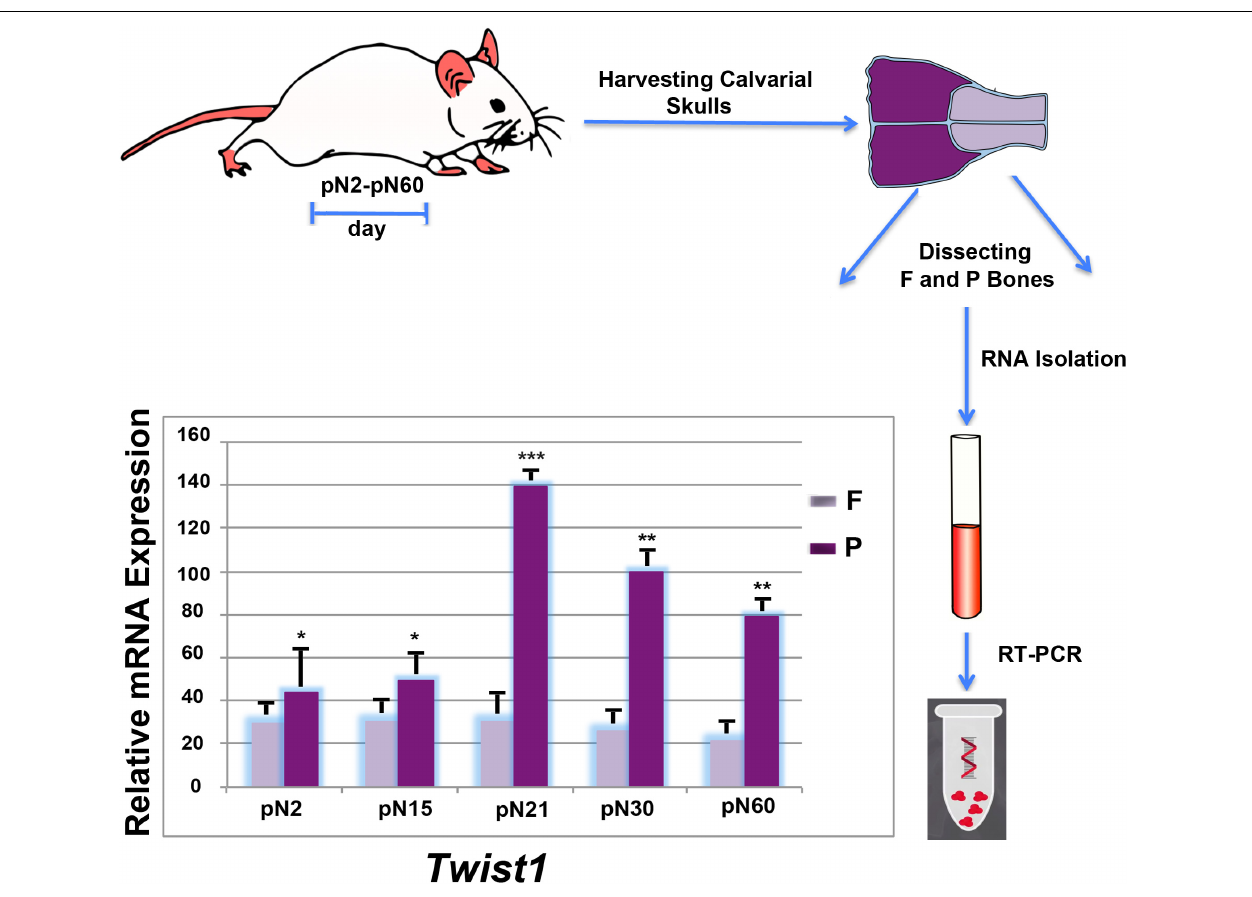
FIGURE 1 | Differential postnatal expression of Twist1 in frontal and parietal bones. Time-course RT-qPCR analysis performed on frontal and parietal bone tissues ( n = 10) revealed a differential expression of Twist1 with higher levels in parietal bone. The relative mRNA level in each sample is normalized to housekeeping gene Gapdh . Values are presented as relative to Gapdh expression. Values: ∗ p ≤ 0.05, ∗∗ p ≤ 0.01, and ∗∗∗ p ≤